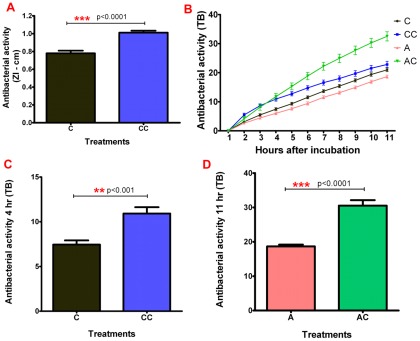
Antibacterial activity in Rhodnius prolixus 5th-instar nymphs challenged by Trypanosoma cruzi Dm28c clone.
Anterior midgut samples collected nine days after feeding and infection. (A) Inhibition zone (ZI) assay incubated for 24 h at 37°C. (B) Turbidometric (TB) assay incubated for 11 h with readings at each hour. (C) Turbidometric (TB) assay after 4 h of incubation of uninfected or infected control insects. (D) Turbidometric assay after 11 h of incubation of insects treated with antibiotic alone or with antibiotic and then infected. Treatments: C – control insects fed on blood alone; CC – parasite infected insects; A – insects treated with antibiotic; AC- insects treated with antibiotic and then infected with parasites. Each bar represents mean ± SEM of four experiments, n = 6–10 insects for each determination. Means were analyzed by using t Test, Mann Whitney test and 2 way ANOVA.